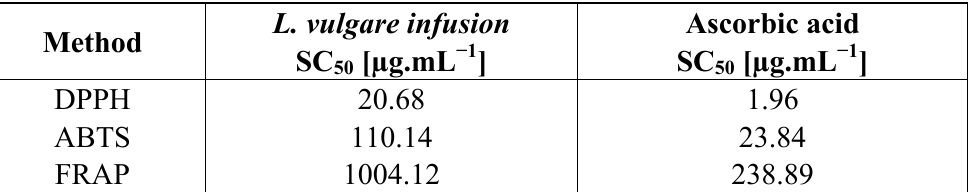
Table 1. SC values of antiradical activity of lyophilized infusion from Ligustrum vulgare 50 leaves compared with ascorbic acid.